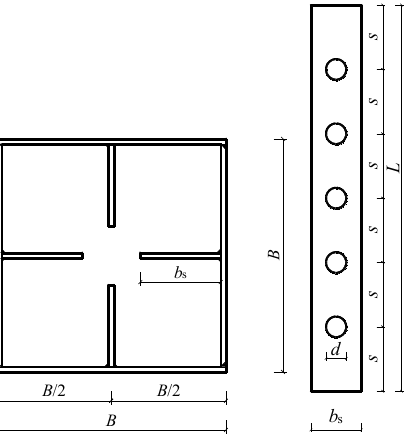
Figure 2. Concrete-filled steel tubular columns with PBL stiffeners.